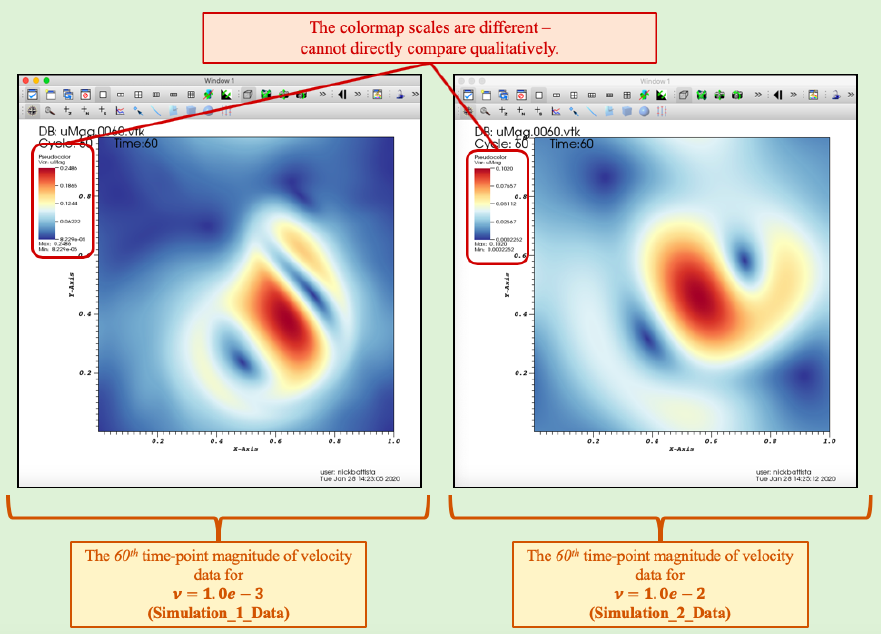
Figure 13. Comparing the data between both simulations’ last time-point (60th time-point stored). Note that a direct qualitative comparison is not possible because the scaling of each colormap is